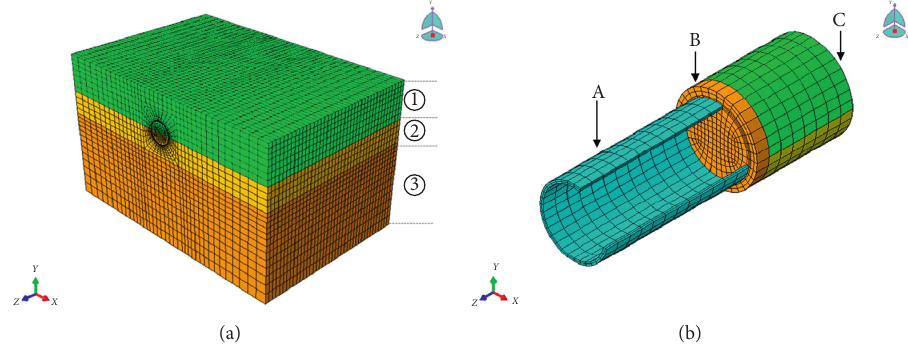
Figure 8: Three-dimensional coupled fluid-solid numerical model. (a) The meshed numerical model. (b) Schematic diagram of the model components. (1) Fine sand; (2) highly weathered conglomerate; (3) medium-weathered conglomerate. A, lining unit; B, slurry penetration zone (unloading unit); and C, soil element in front of the shield.